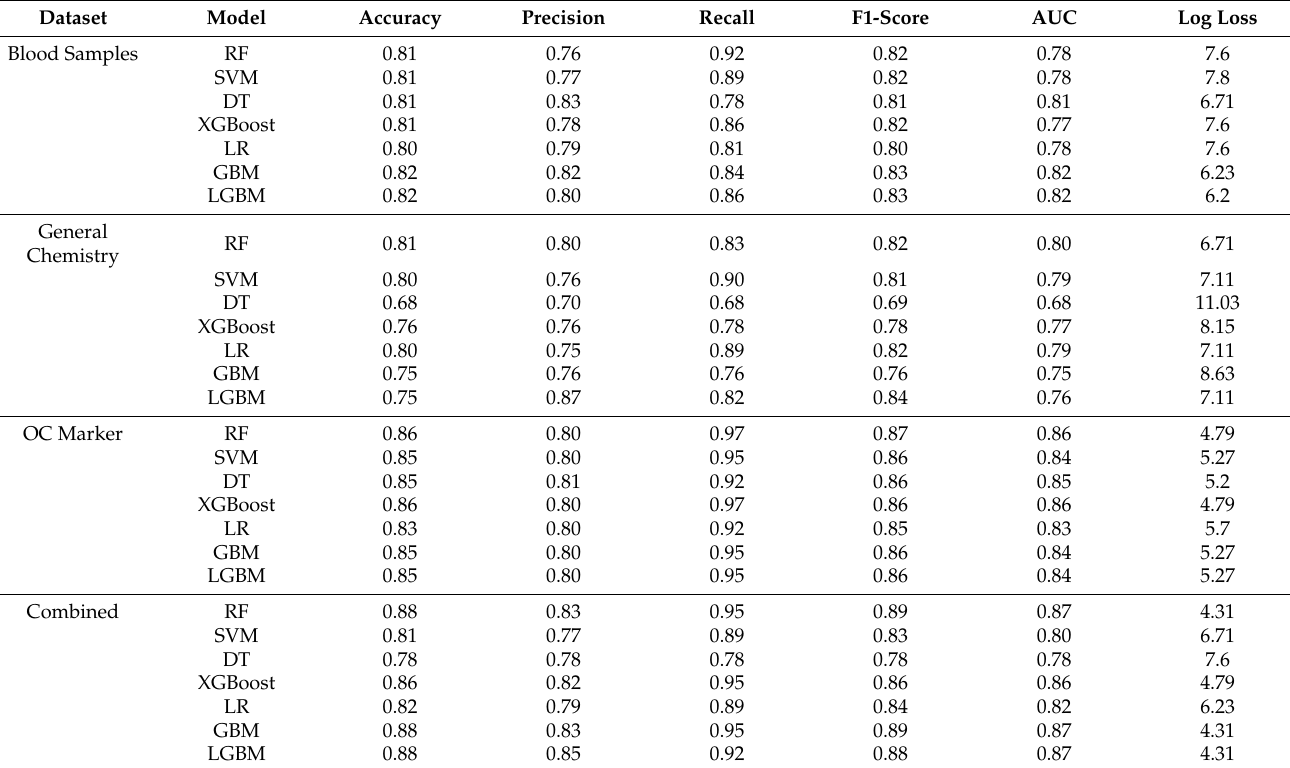
Table 3. Accuracy and evaluation matrices scores for each of the data groups.